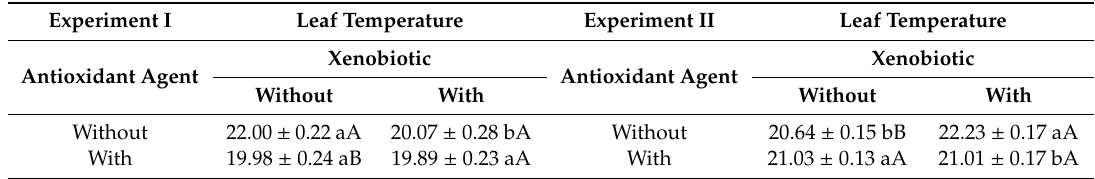
Table 2. Leaftemperature( ◦ C)insoybeanplantssubmittedtoxenobioticandantioxidantagentapplications. Experiment I